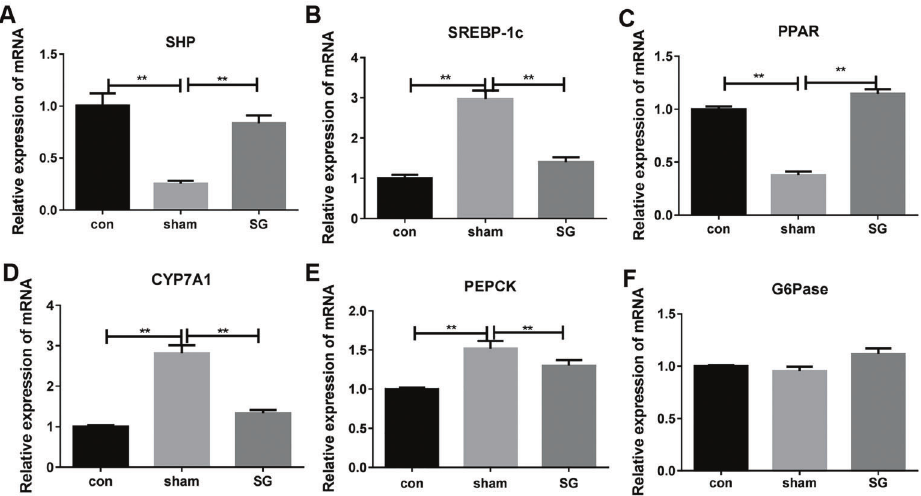
Figure 4 . mRNA levels of six FXR-regulated genes, SHP ( A ), SREBP ( B ), PPAR ( C ), CYP7A1 ( D ), PEPCK ( E ), and G6pase ( F ) in livers of diabetic rats that underwent sleeve gastrectomy (SG) or sham surgery analyzed by quantitative RT-PCR. GAPDH was applied as the internal control in qRT-PCR analyses. Con: control group; SHP-1: small heterodimer partner 1; SREBP-1: sterol regulatory element binding protein-1; PPAR a : peroxisome-proliferator-activated receptor a ; CYP7A1: cholesterol 7 a -hydroxylase gene (CYP7A1); PEPCK: phosphoenolpyruvate carboxykinase; G6Pase: glucose-6-phosphatase. Data are reported as means ± SD. **P o 0.01 ( t